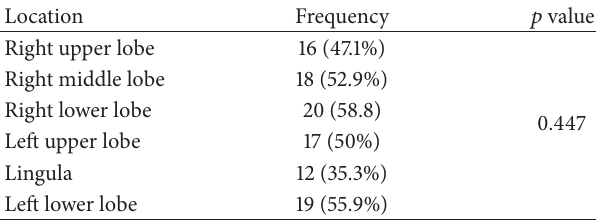
Table 3: Frequency of locations of nodules under one centimeter.